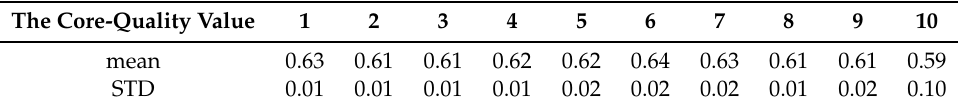
Table A5. The average and standard deviation (STD) core-quality values for the core-periphery structures in the 10